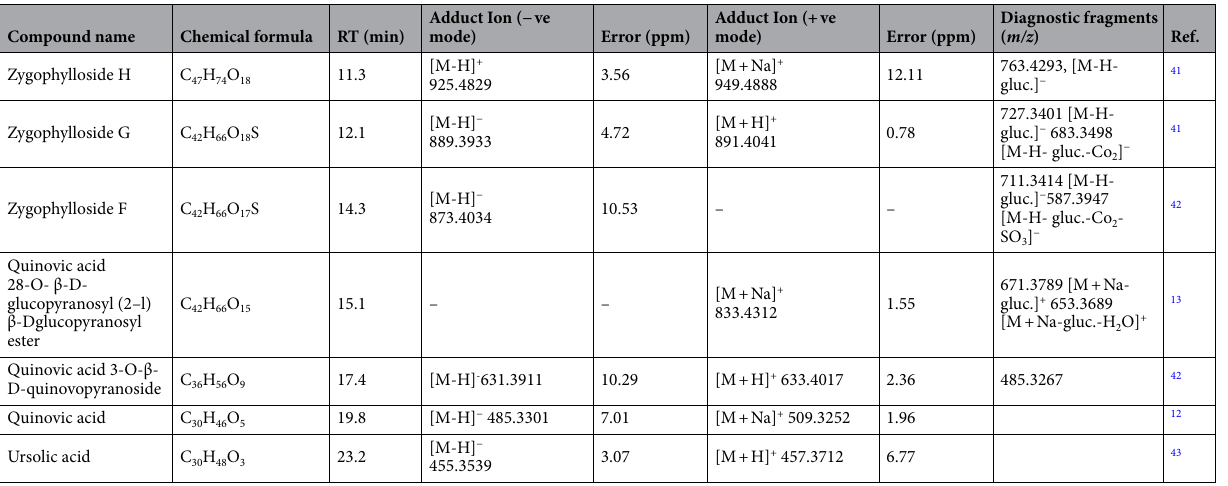
Table 4. Peak annotations of major saponins in Zygophyllum album using UPLC- QTOF-MS in negative and positive ionization modes.